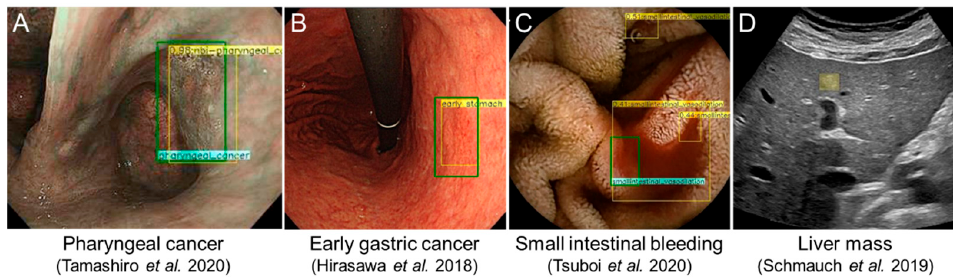
Figure 3. Representative images of AI-aided endoscopies and ultrasonography. ( A ) Pharyngeal cancer detected by AI with narrow-band imaging. Adapted from (Tamashiro A, Dig Endosc 2020) [32]. ( B ) Early gastric cancer detected by an AI system. Adapted from (Hirasawa T, Gastric Cancer 2018) [35]. ( C ) Small intestinal bleeding detected by an AI system. Adapted from (Tsuboi A, Dig Endosc 2020) [36]. ( D ) A liver mass detected by an AI system. Adapted from (Schmauch B, Diagn Interv Imaging 2019) [37].